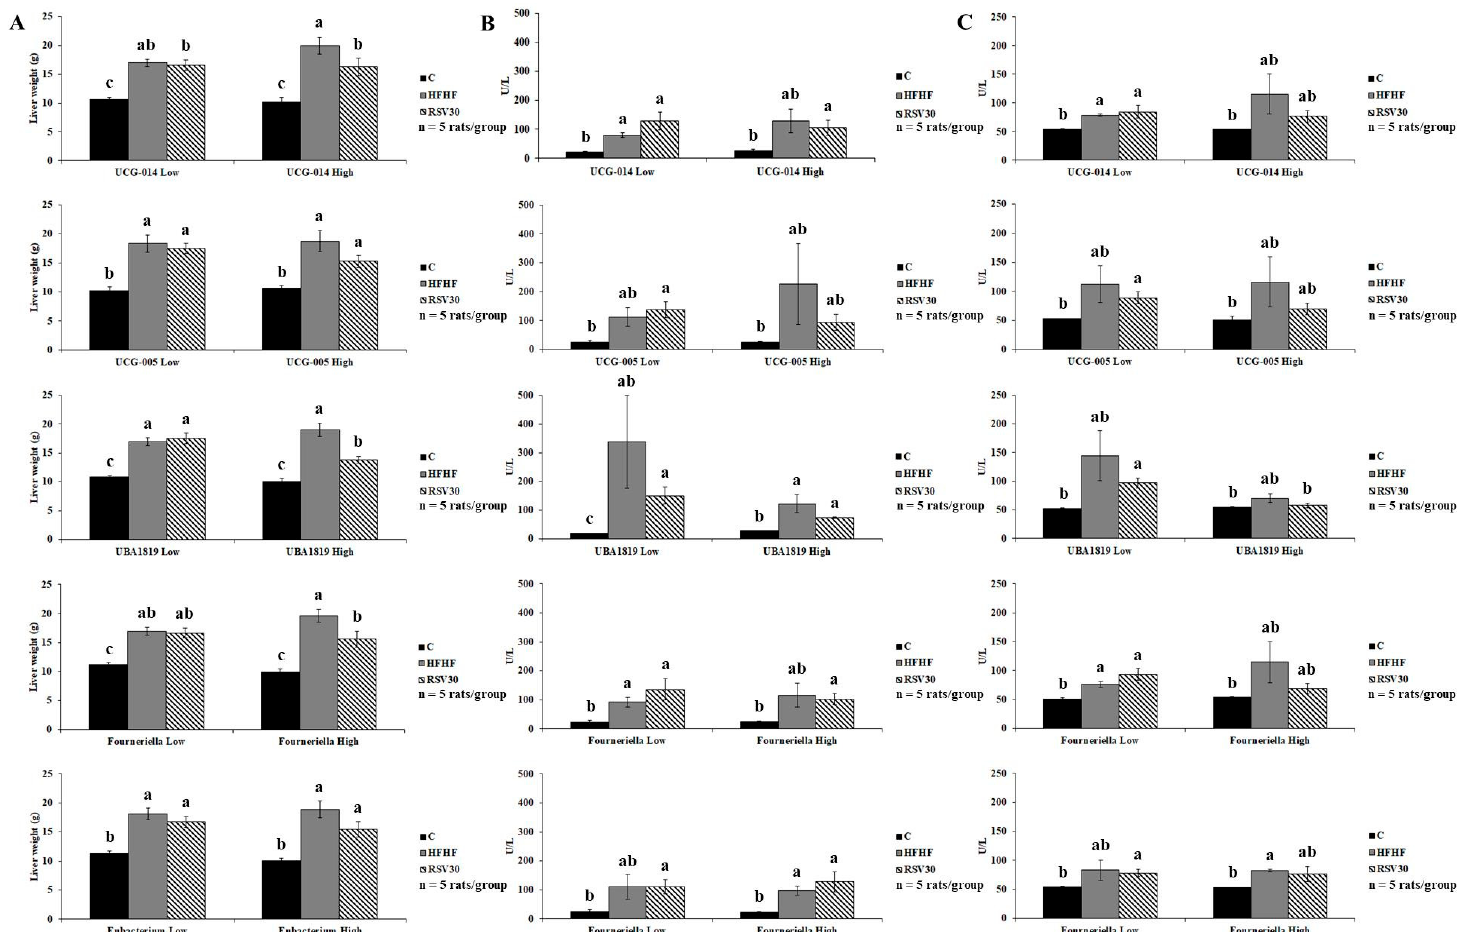
Figure 4. Graphic representation of liver weight ( A ), serum ALT ( B ) and serum AST ( C ) levels according to the relative abundance of Ruminococcaceae UCG-014, Ruminococcaceae UCG-005, UBA-1819 , Fourneriella and Eubacterium corpostalonigenes in rats fed a control diet ( C ), a high-fat high-fructose diet (HFHF) or a high-fat-high-fructose diet supplemented with 30 mg/kg/d resveratrol (RSV30). Values are presented as mean ± SEM. Bars not sharing common letters are significantly different ( p < 0.05). ALT: alanine aminotransferase, AST: aspartate aminotransferase.